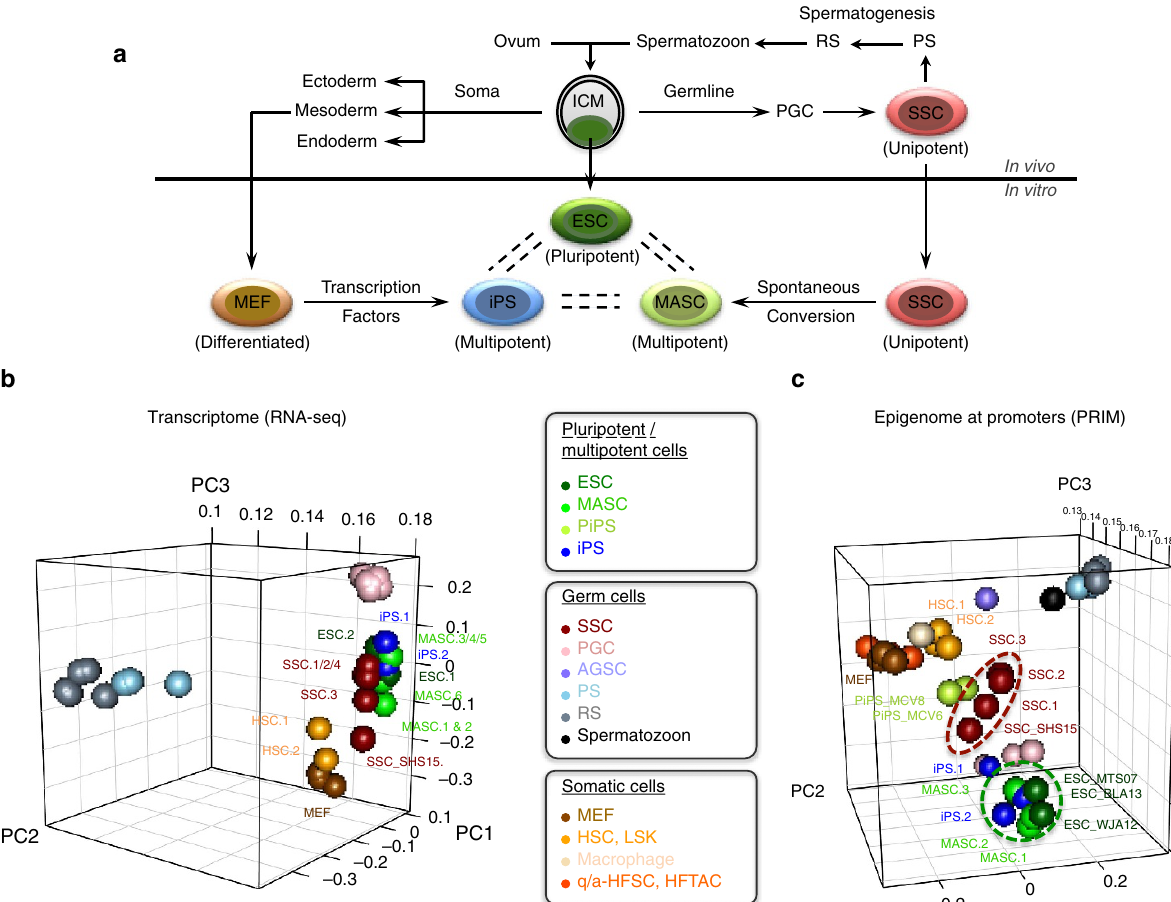
Figure 1 | Comparison of transcriptomes and epigenomes among different cell types. ( a ) Cell type and developmental potency. Dark green, ESC and inner cell mass (ICM); green, MASC; red, SSC; blue, iPS cell; brown, MEF. Other male germ cells include PGC, pachytene spermatocyte (PS), round spermatid (RS) and spermatozoon. ( b ) Three-dimensional (3D) PCA plot based on mRNA expression of all protein-coding and noncoding genes. Dark green, ESCs; green, MASCs; blue, iPS; light green, incompletely reprogrammed MEFs (PiPS); red, SSC; pink, PGCs; brown, MEFs; dark orange, quiescent/ activated-hair follicle stem cell (q/a-HFSC) and hair follicle transient-amplifying matrix cell (HFTAC); orange, HSC from culture or fluorescent-activated cell sorting (FACS)-isolated lineage (cid:2) , Sca-1 þ and c-kit þ (LSK) cells; light orange, macrophage; slate blue, FACS-isolated Thy1 þ adult germline stem cell (AGSC); sky blue, PS; grey, RS; black, spermatozoon. ( c ) 3D PCA plot based on PRIMs of all protein-coding and noncoding gene promoters with K4me3 and/or K27me3 modification. PRIM is calculated by read intensity ratio between K4me3 and K27me3 peaks at the same promoter region (log2(K4me3/ K27me3)). Different cell types are distinguished by colours as in b